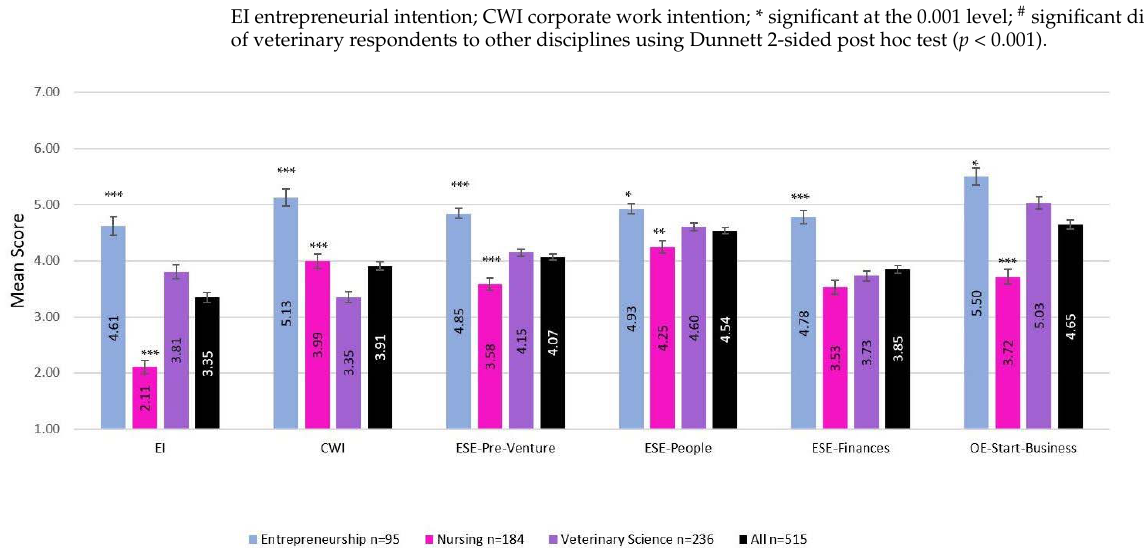
Table 4. Means and standard deviations of entrepreneurial and corporate work intention by field ‐ of ‐ study and gender (n = 515). Field ‐ of ‐ Study